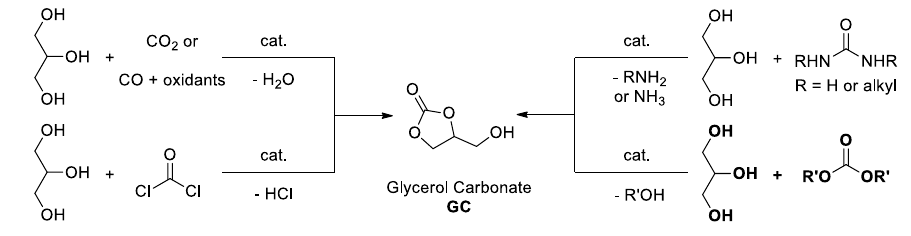
Figure 3. Diverse syntheses of glycerol carbonate.